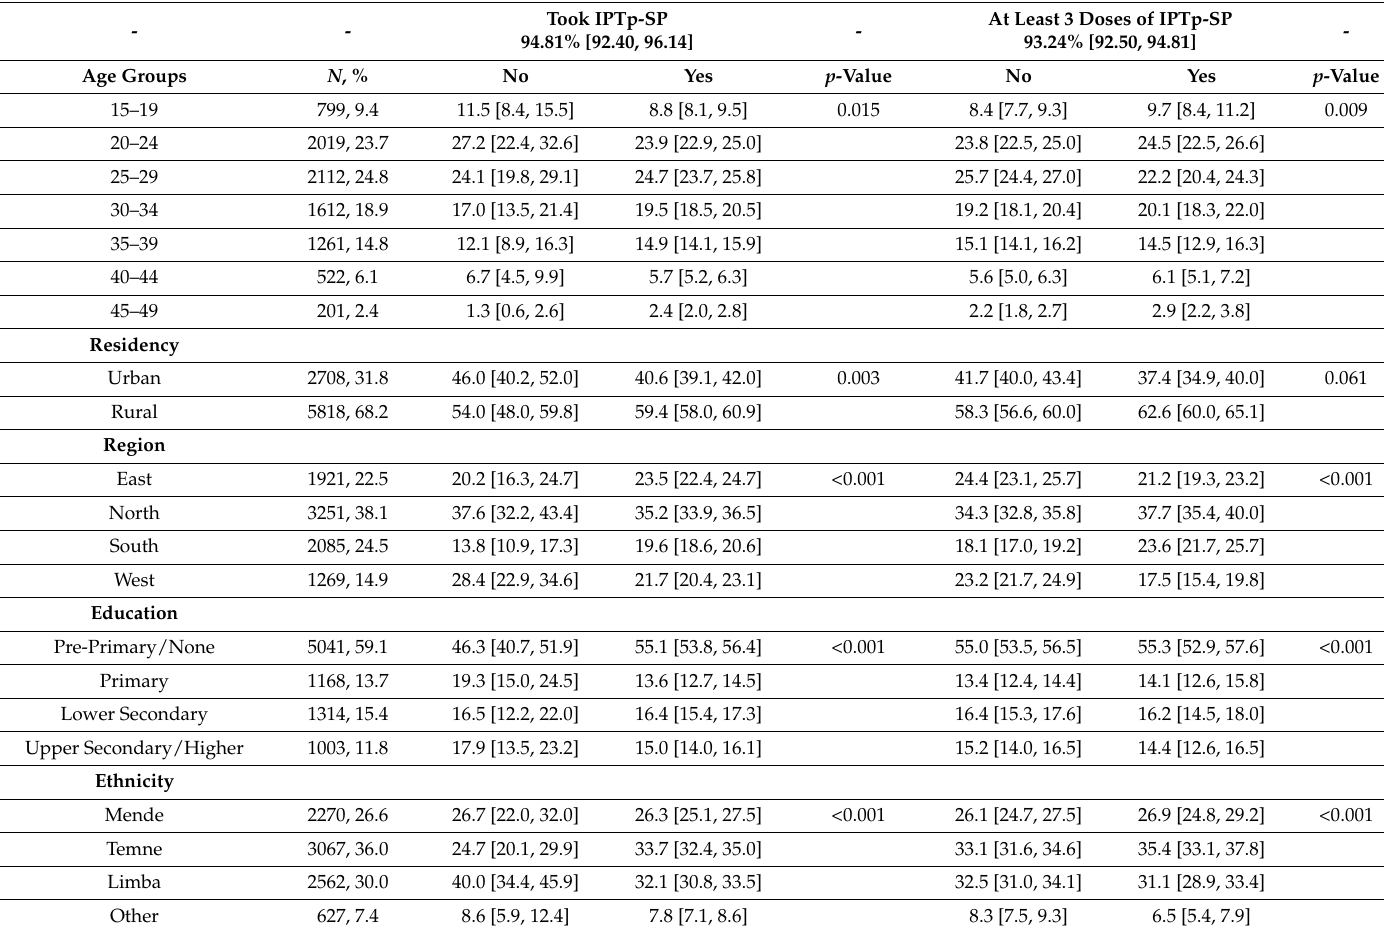
Table 1. Prevalence of taking sulfadoxine-pyrimethamine (IPTp-SP) in Sierra Leone ( n =